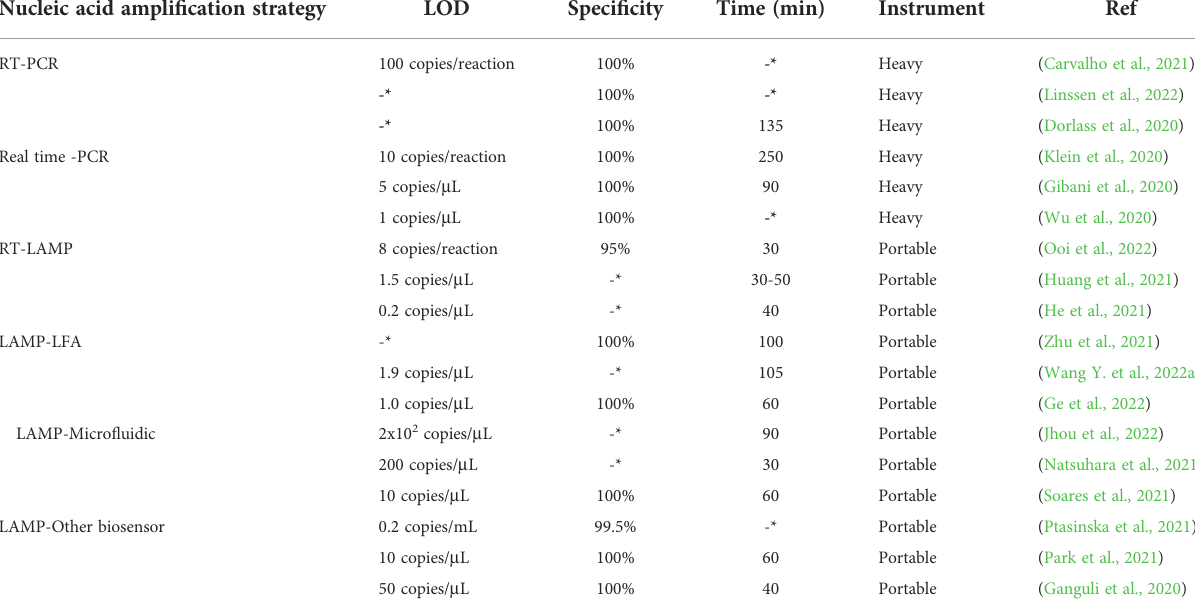
TABLE 1 Detection of SARS-CoV-2 based on different nucleic acid ampli fi cation strategies. Nucleic acid ampli fi cation